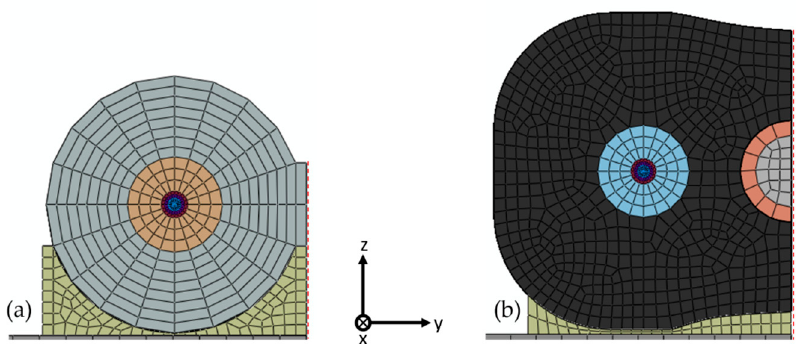
Figure 7. Meshed numerical models with a material-dependent mapping color. First cable prototype ( a ) and second cable prototype ( b ).